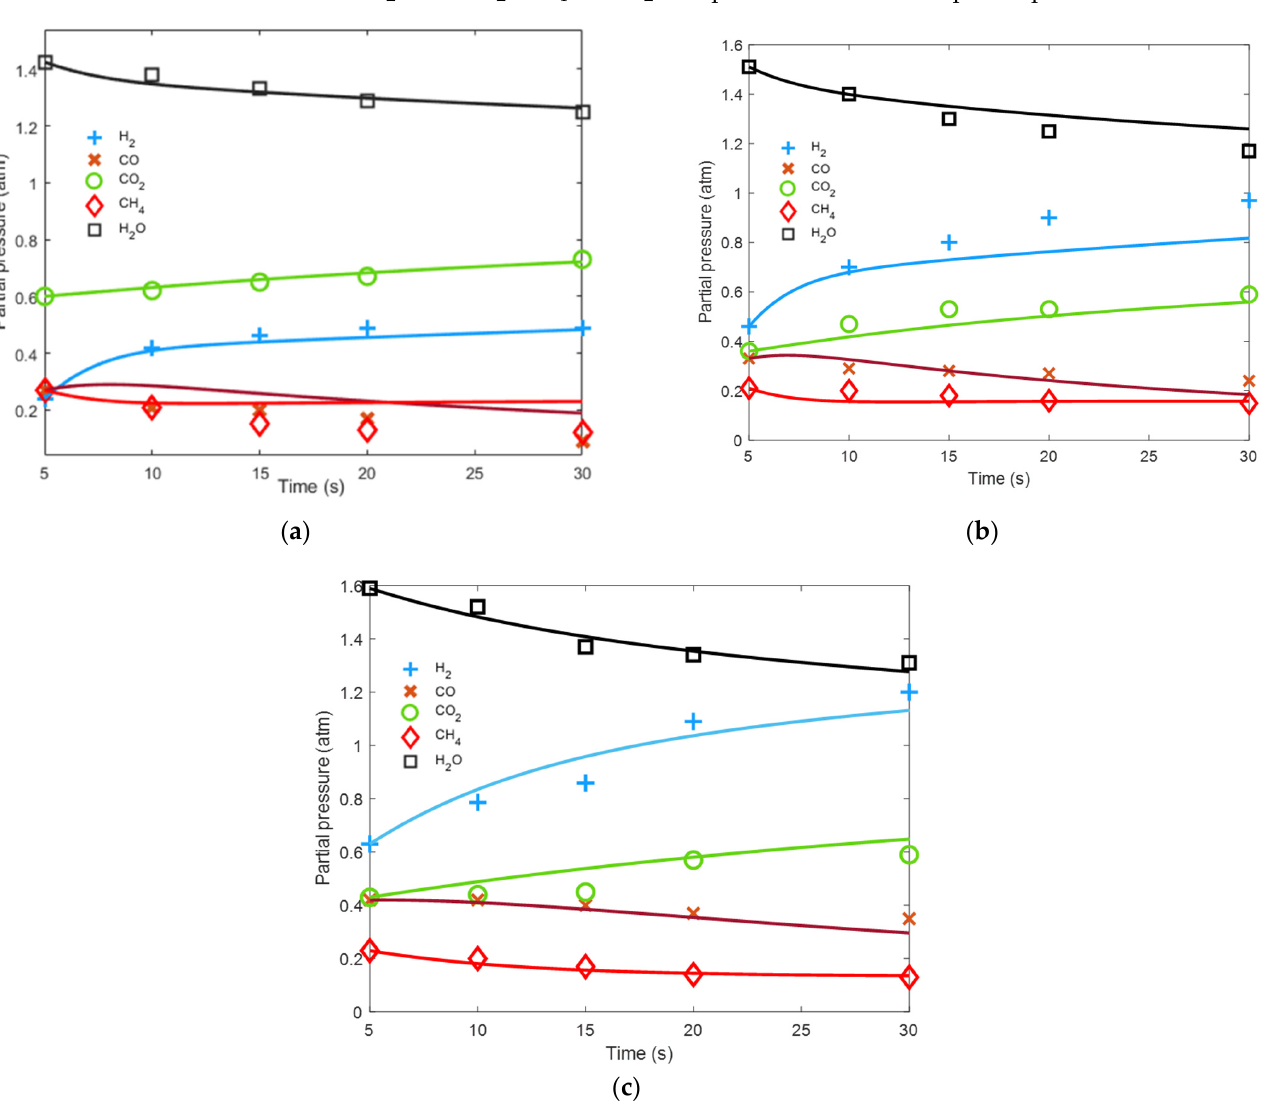
° , E y E (cid:3439) obtained in the (cid:2907)(cid:2891)(cid:2903) (cid:2903)(cid:2902)(cid:2897) (cid:2903)(cid:2902)(cid:2897)